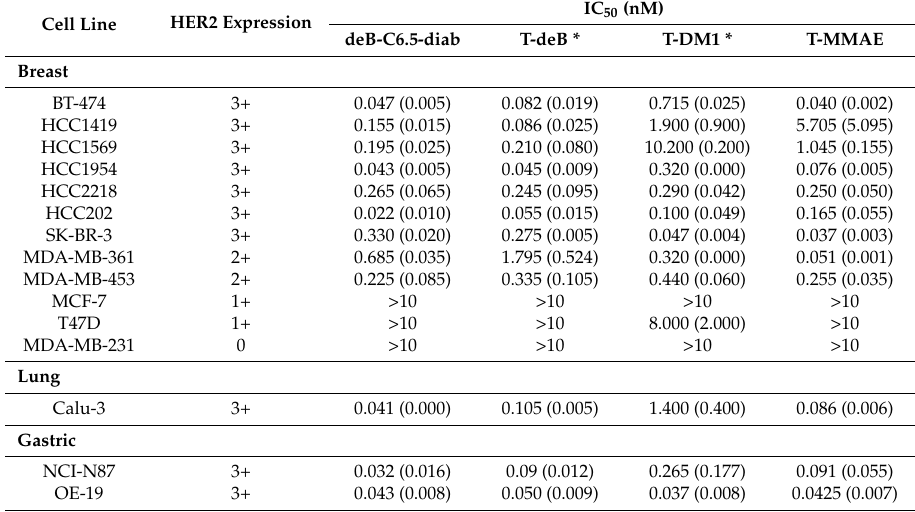
Table 1. Potency of deB-C6.5-diab, T-deB, T-DM1, and T-MMAE against carcinoma cell lines.